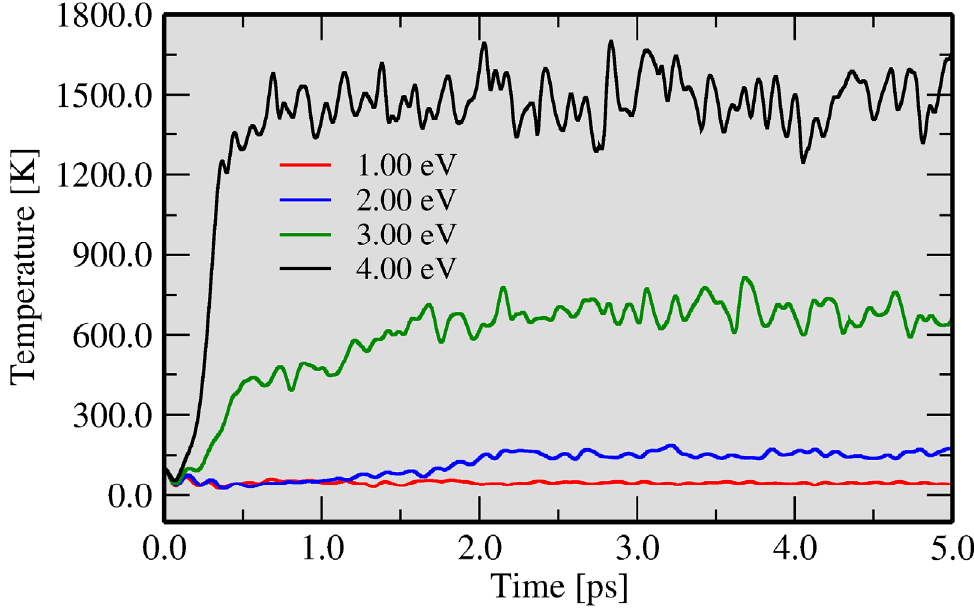
Figure 5. Ab initio molecular dynamics with the excited atoms: temperature evolution as a function of time for calculated electronic temperatures of 1.00 eV (red), 2.00 eV (blue), 3.00 eV (green) and 4.00 eV (black).